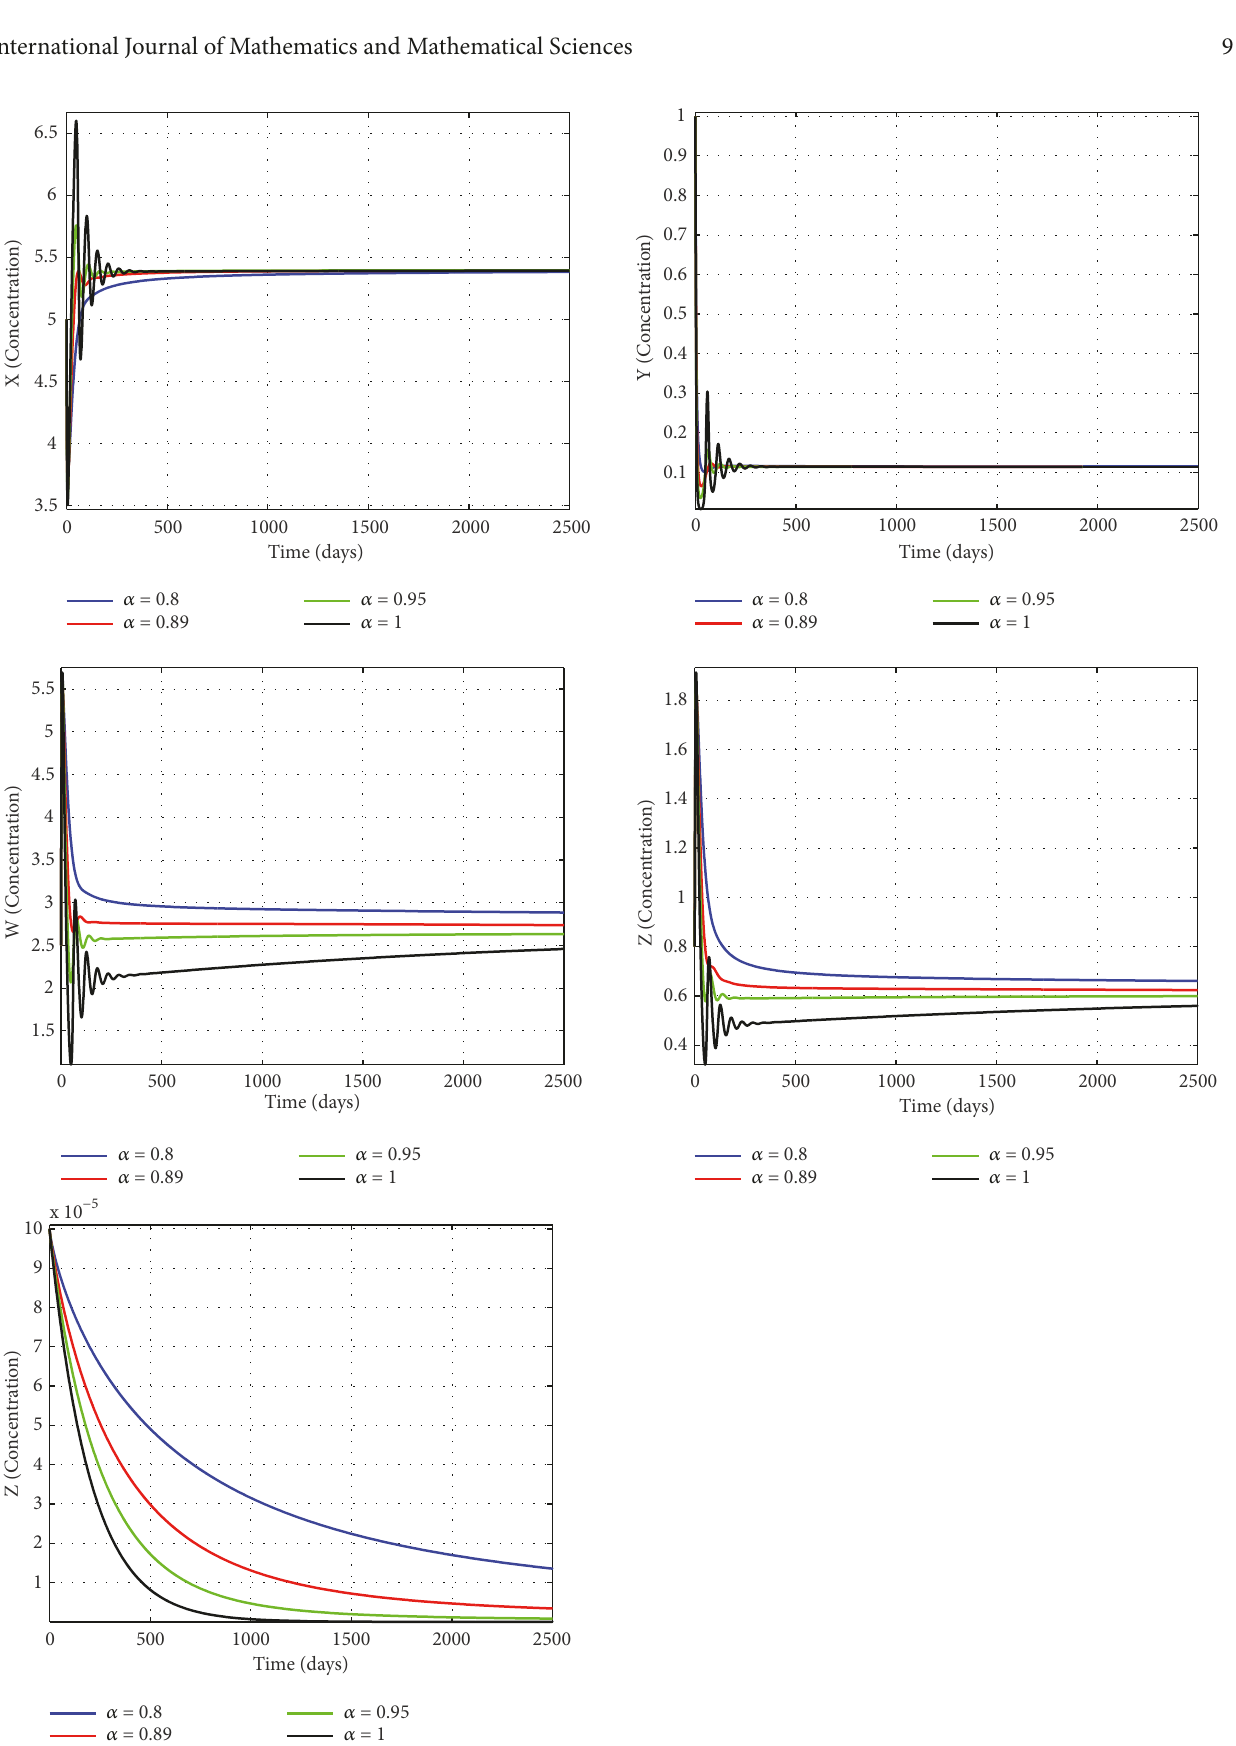
Figure 4: The dynamics of fractional order mathematical model of HSCs gene-based therapy for control immune